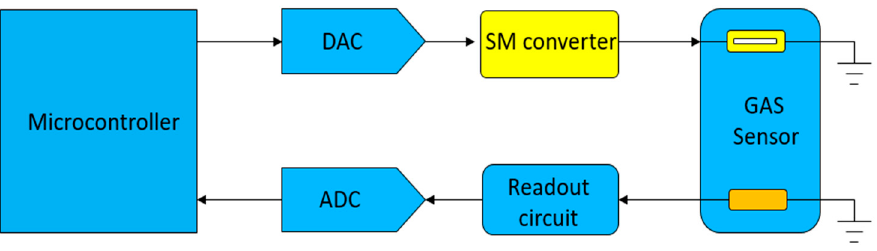
Figure 2. Architecture of proposed system.